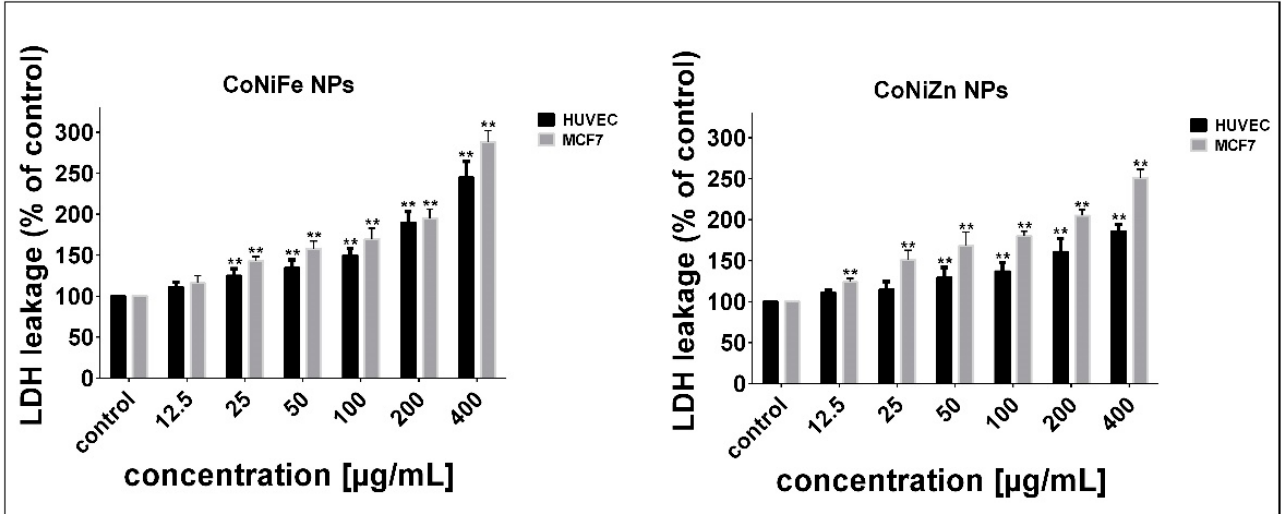
Figure 6. LDH leakage caused by CoNiZn and CoNiFe NPs following 48 h of exposure. Data are expressed as mean ± SD from one representative of three independent experiments (** p < 0.05 compared with untreated cells).